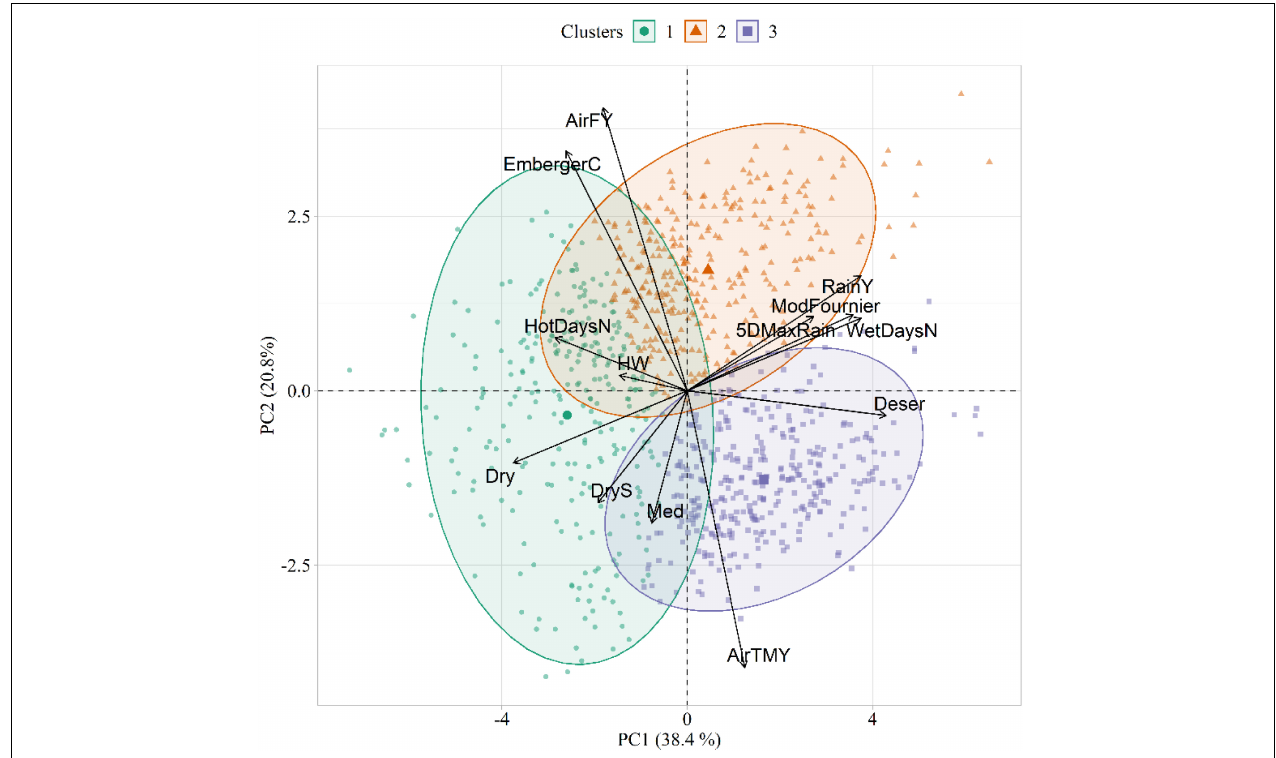
FIGURE 4 | Biplot showing the agrometeorological indices in the principal component (PC) space, as well as the three clusters extracted in the first two PCs. The acronyms of the agrometeorological indices are reported in Table 1 .